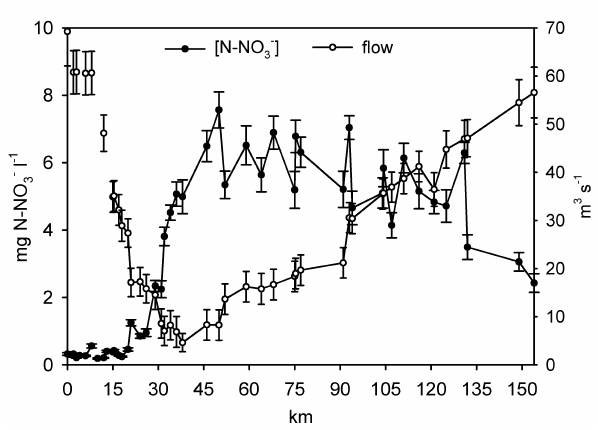
Fig. 2. Concentration of nitric nitrogen and water flow in the Oglio River during summer season. Values are averages ( ± standard